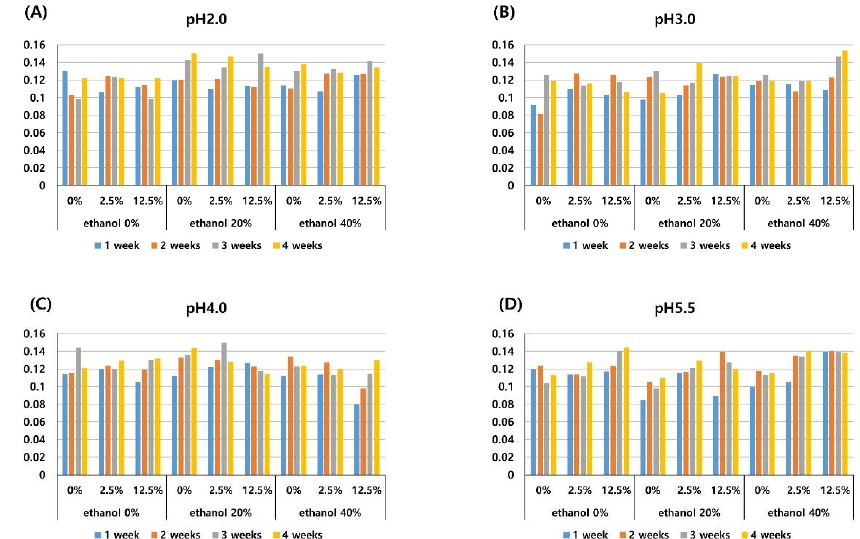
Figure 5. Mean surface roughness values (R a ) of the composite resin after different periods of storage (1-, 2-, 3-, and 4-weeks) in media of pH 2.0 ( A ), pH 3.0 ( B ), pH 4.0 ( C ), pH 5.5 ( D ) with three different pigment concentrations (0%, 2.5%, 12.5%), and three different ethanol concentrations (0%, 20%, 40%).